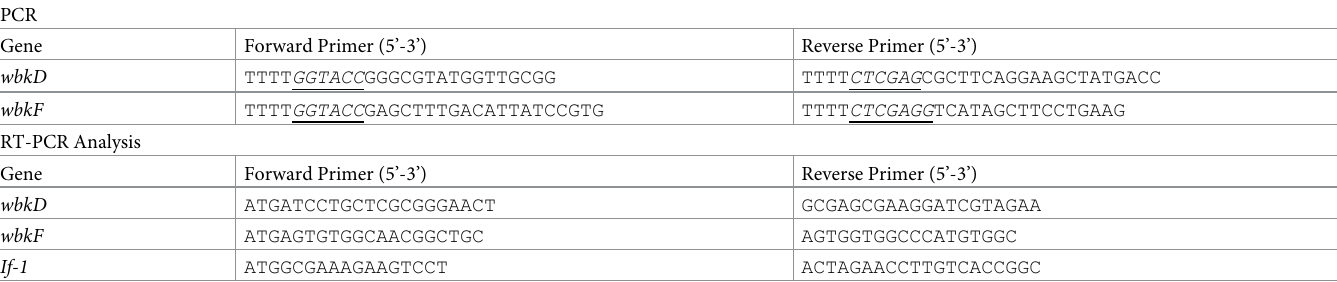
Table 1. Primers used in this study for PCR gene amplification and for RT-PCR.